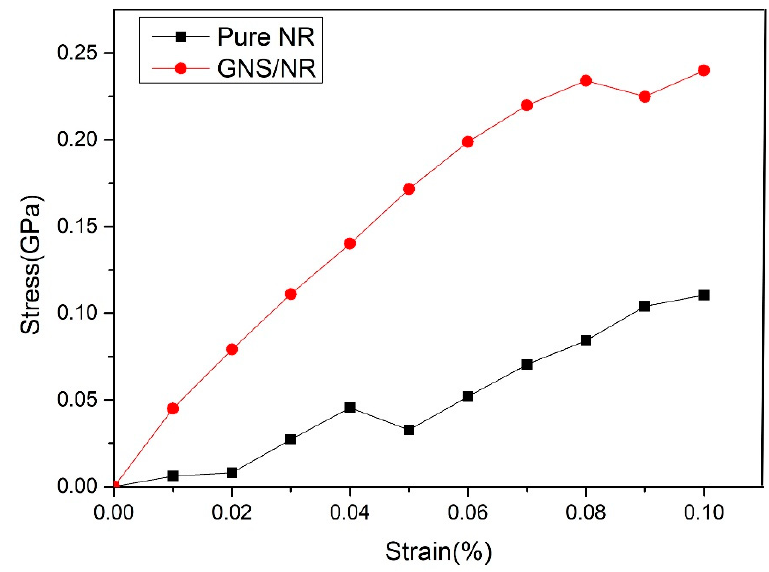
Figure 3. Stress-strain curves of the pure NR and GNS/NR composites.